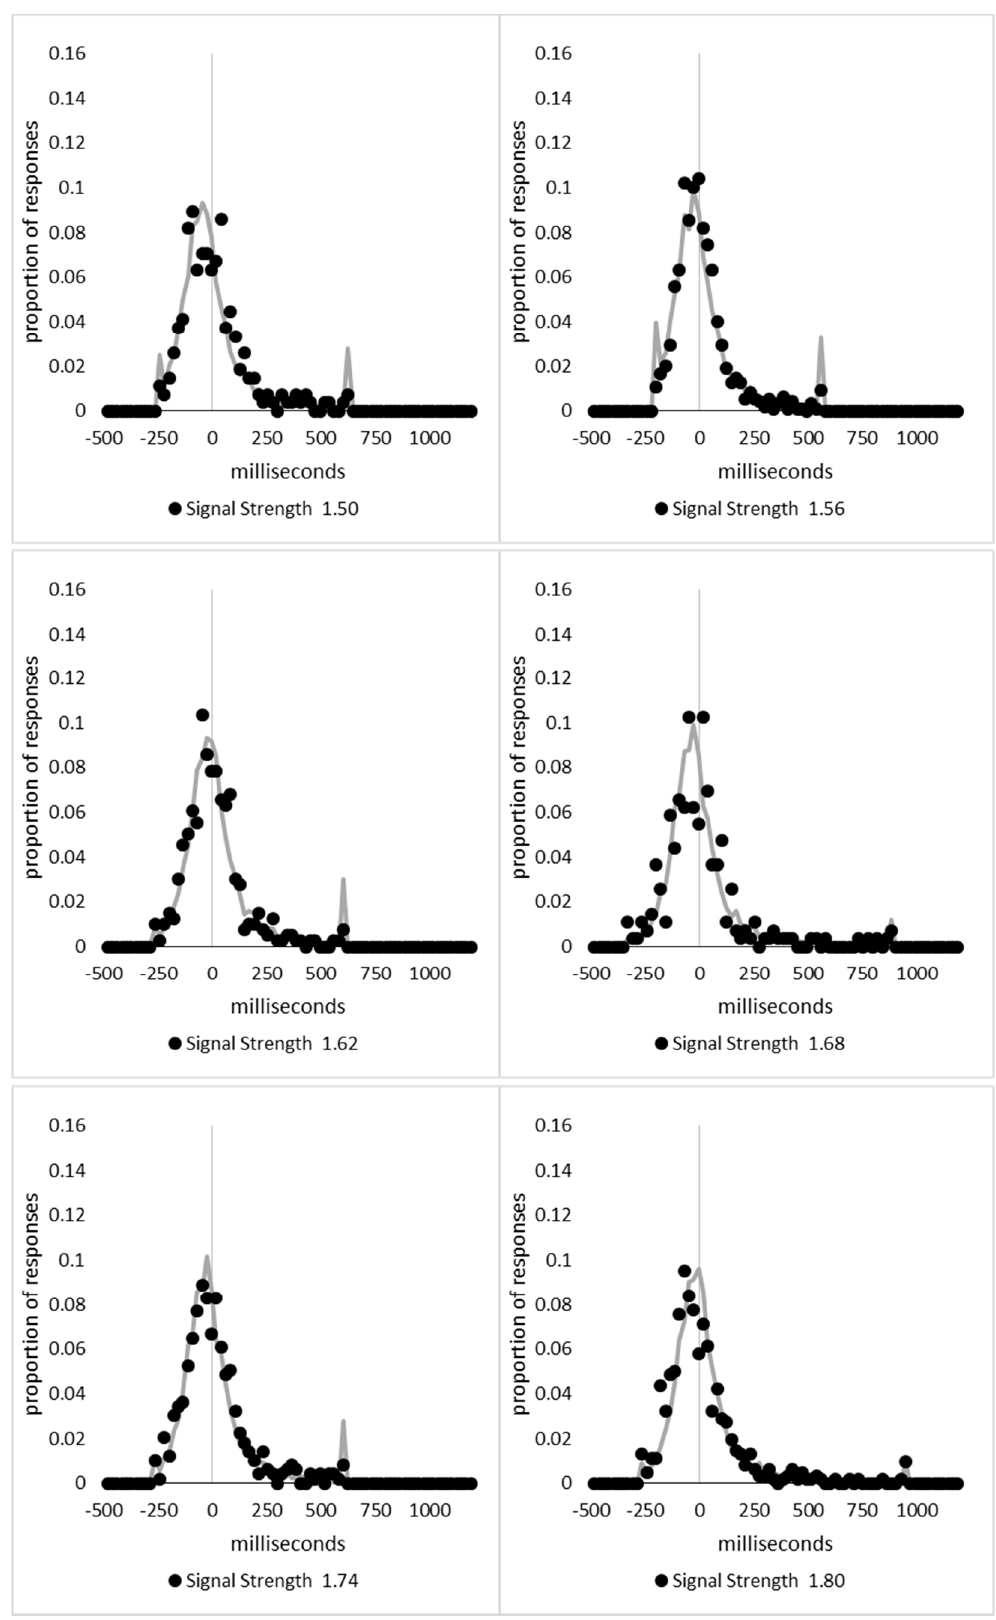
Figure A5. Density functions of the observed data (filled circles) and model (solid line) for signal strength bins 1.50 to 1.80.